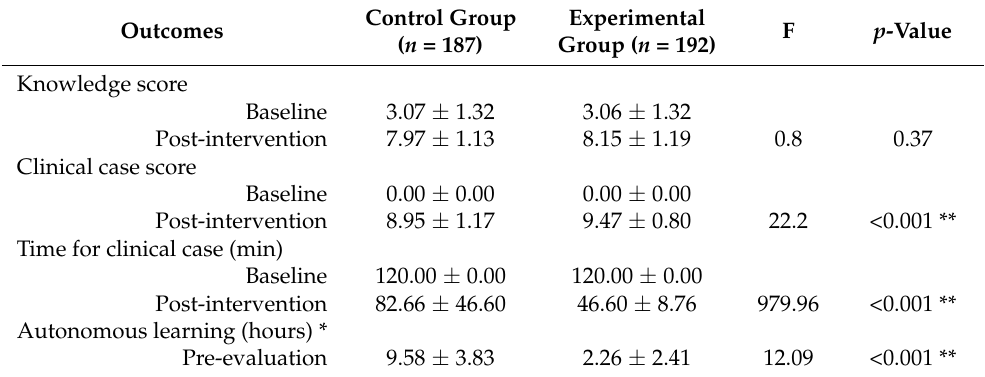
Table 2. Comparison of knowledge and skills between groups before and after the